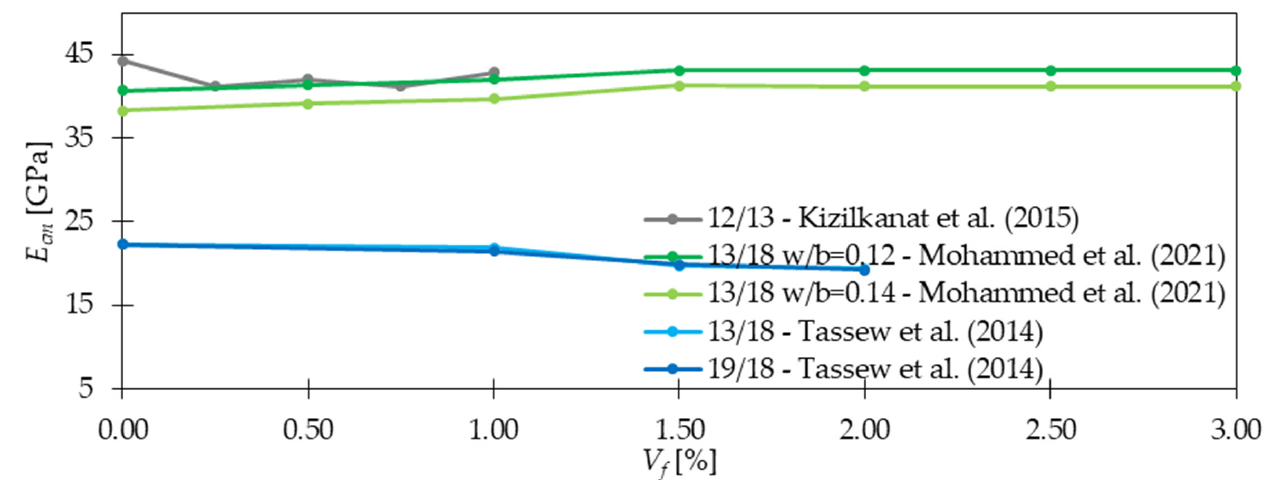
Figure 7. Influence of V f on E cm for different fiber geometry l f /d f [22,35,54].